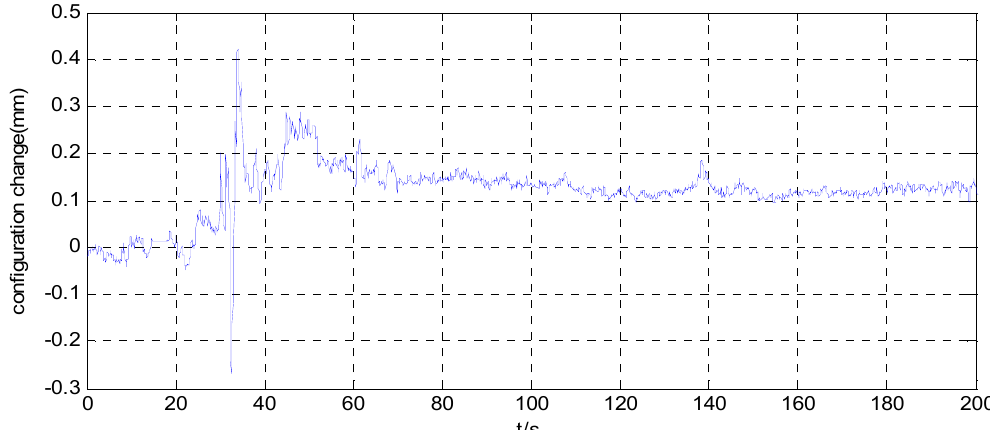
Figure 16. Relative angle error inside the simulator when